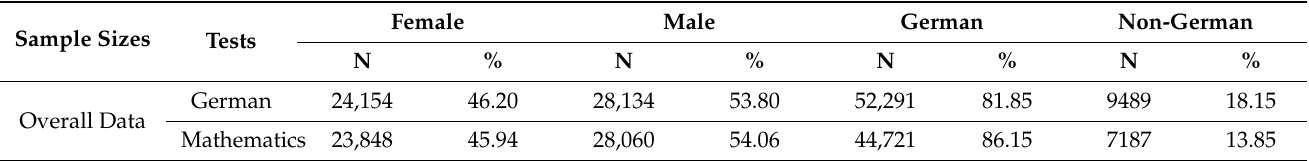
Table 2. Sample size of subgroups in the